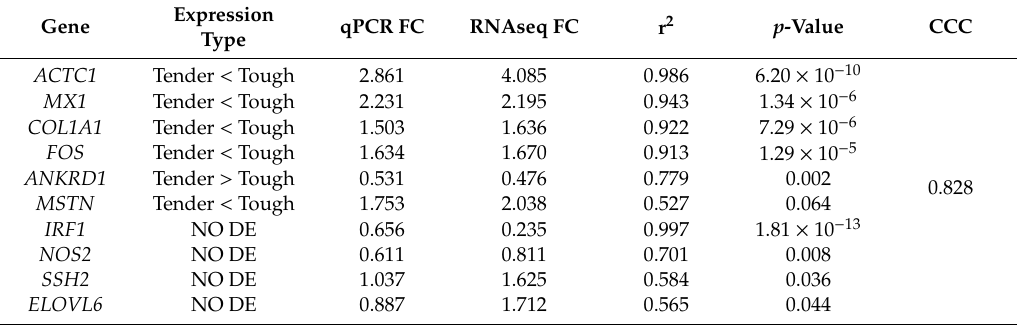
Table 6. Technical validation of RNA-seq results by quantitative PCR (qPCR): Fold Change values (FC), Pearson correlations (r 2 ) and Concordance Correlation Coe ffi cient (CCC) between expression values obtained from both